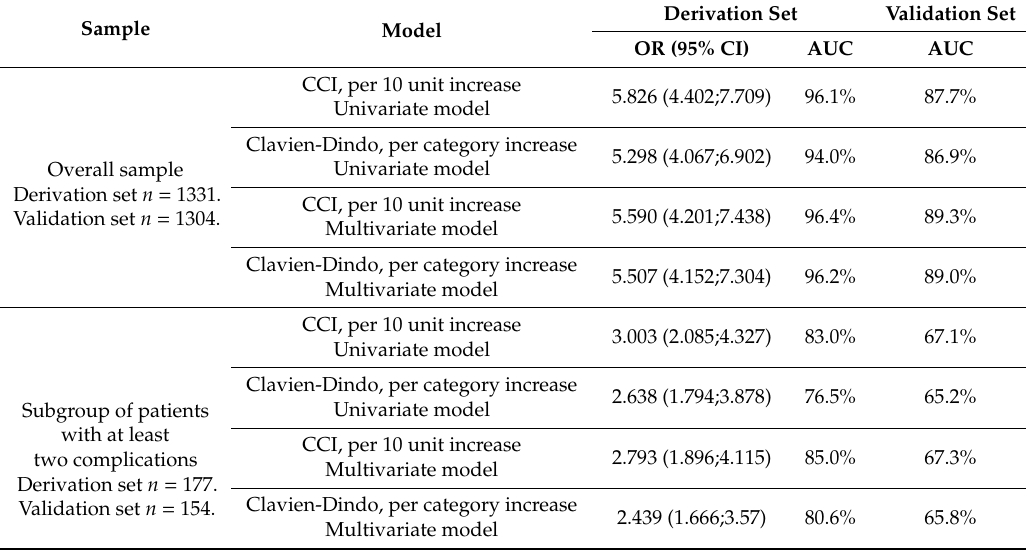
Table 3. Logistic regression analysis for e-LOS (LOS ≥ 15 days). The univariate models include CCI or Clavien-Dindo as the only covariate. The multivariate models are adjusted for the following covariates: type of surgery (major vs. minor), open vs. laparoscopy, age (per year), ASA score (1–2 vs. 3–4), Child grade (A vs. B), and duration of surgery ( > 4 h vs. ≤ 4 h), center volume (high vs. medium or low). Patients died during hospital stay are excluded from all